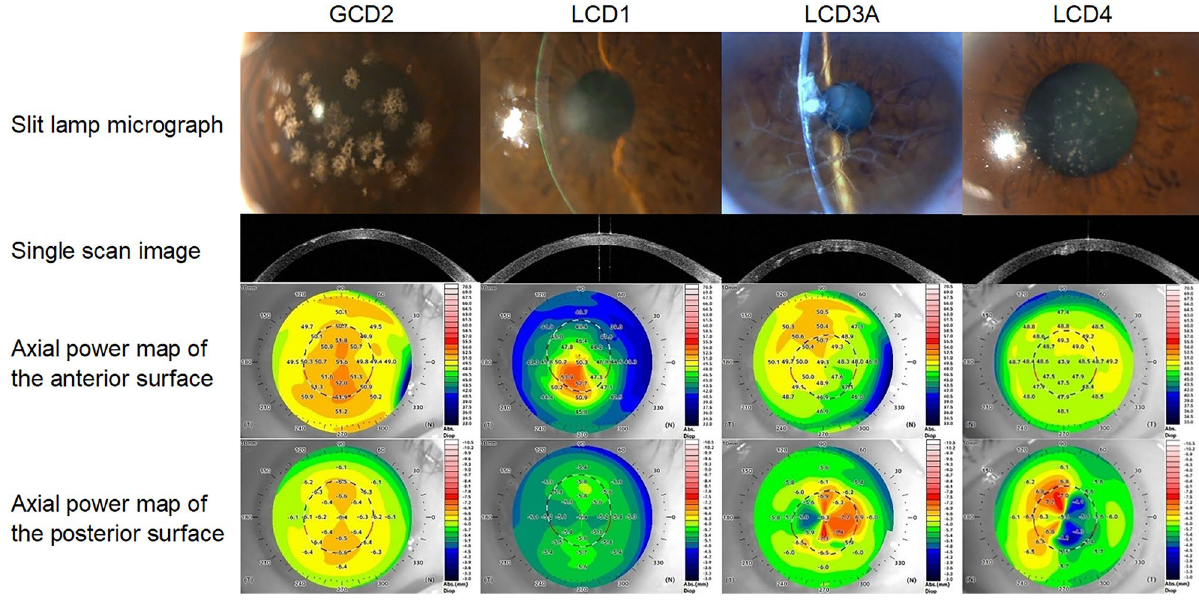
Figure 1. Representative example of AS-OCT image and topographic map in one case analyzed in this study. The BCVA of each case was 20/28, 20/400, 20/50 and 20/100. AS-OCT = anterior segment optical coherence tomography, BCVA = best-corrected visual acuity, GCD2 = granular corneal dystrophy type 2, LCD1 = lattice corneal dystrophy type 1, LCD3A = lattice corneal dystrophy type IIIA, LCD4 = lattice corneal dystrophy type